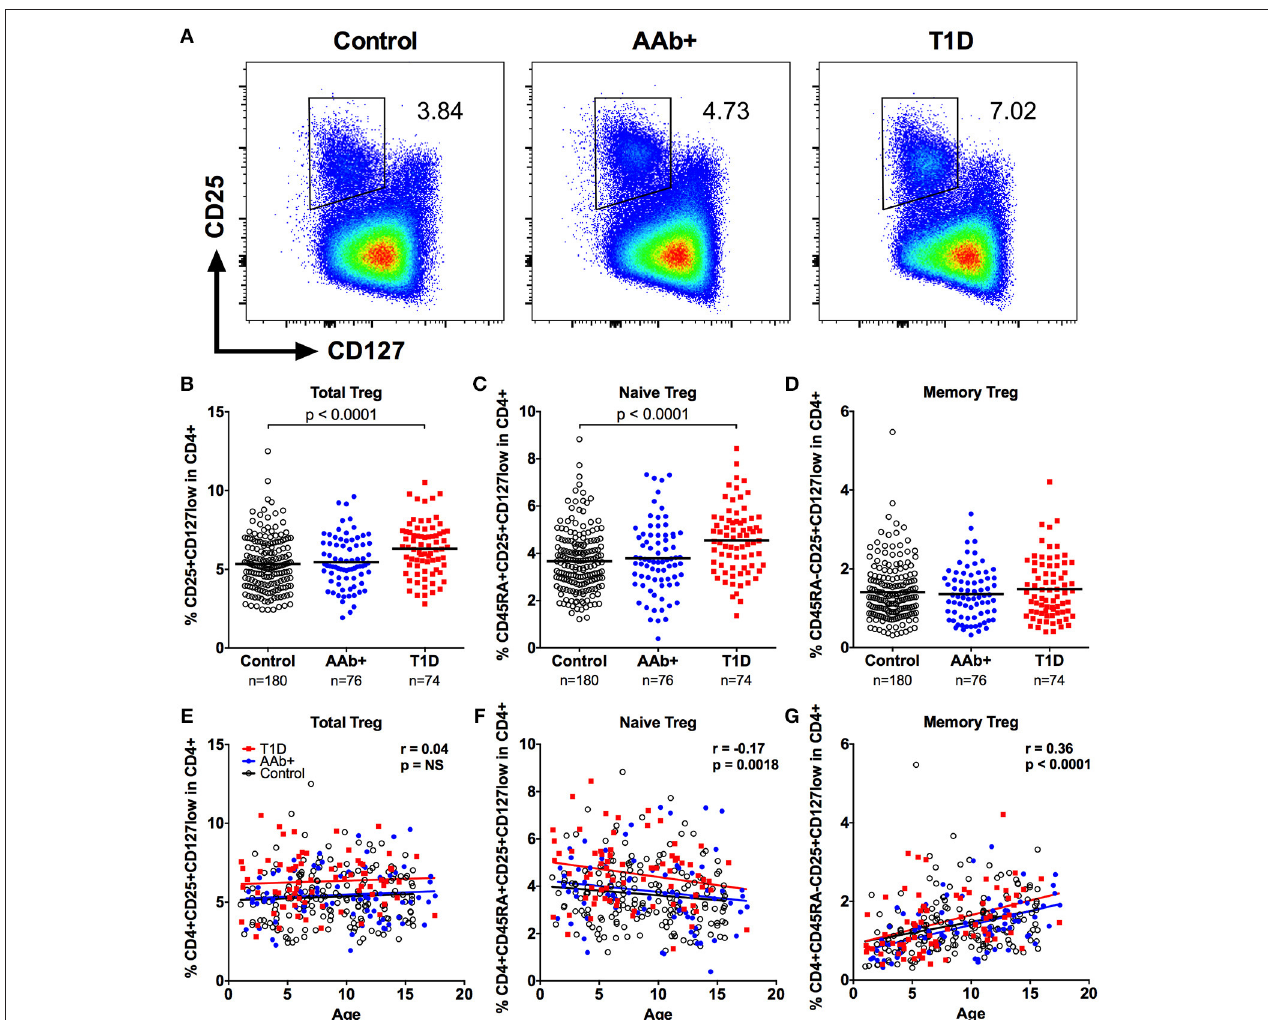
FIGURE 1 | Increased frequency of CD4 + CD25 + CD127low Tregs in children with newly diagnosed T1D. Representative examples of Treg stainings from healthy control children, autoantibody-positive at-risk children (AAb + ) and children with newly diagnosed T1D (A) . Frequencies of total (B) , naive (C) , and memory (D) Tregs in control, AAb + and T1D groups. Linear regression lines for total (E) , naive (F) , and memory (G) Treg frequencies against age were calculated for the control (black lines), AAb + (blue lines) and T1D (red lines) groups. The elevations of the regression lines were significantly different between the groups for total and naive